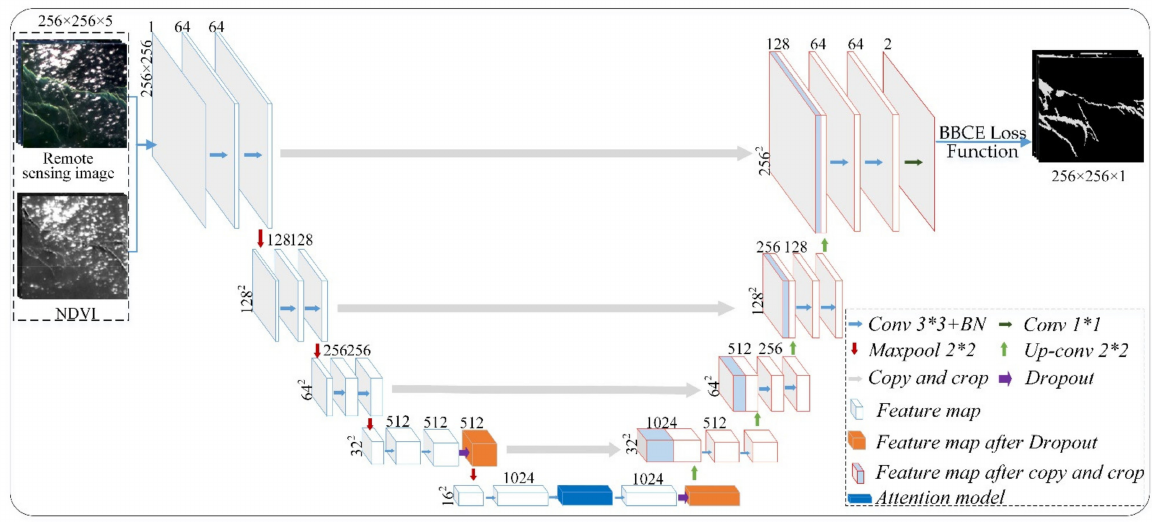
Figure 3. RDU − Net model framework. The blue and red boxes represent the convolutional and up − convolutional layers,